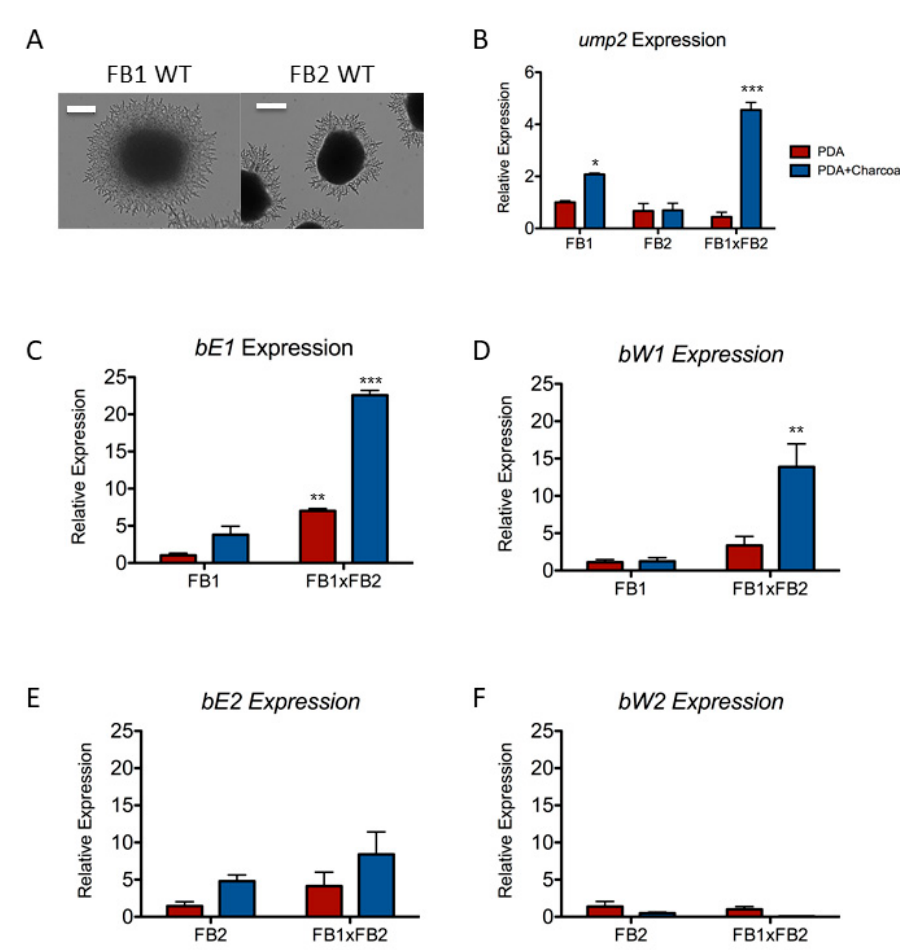
Figure 1. Phenotype of FB1 and FB2 under Low-NH 4 conditions. ( A ) Filamentous phenotype of FB1 and FB2 when grown on PDA media. Scale bars show, for FB1, 100 µ M; for FB2, 200 µ M. ( B ) Differential expression of ump2 on PDA vs. PDA supplemented with 1% activated charcoal. FB1 shows upregulation of ump2 on charcoal, as does the FB1xFB2 mated pair, while FB2 has similar levels of ump2 expression on both media. ( C ) bE1 expression on PDA vs. PDA-charcoal. FB1 expression level of bE1 shows a trend towards significance ( p = 0.07) on PDA-charcoal with respect to PDA. bE1 is significantly upregulated in FB1xFB2 on both PDA and PDA-charcoal. ( D ) bW1 expression on PDA vs. PDA-charcoal. The expression level of bW1 is the same on PDA vs. PDA-charcoal. In the FB1xFB2 mated pair, bW1 expression is significantly increased. ( E ) bE2 expression on PDA vs. PDA-charcoal. No change in bE2 expression was observed on either type of media, even in the mated pair FB1xFB2. ( F ) bW2 expression on PDA vs. PDA-charcoal. A similar trend was observed as with bE2 , with no difference in expression. For measuring relative levels of expression, the Comparative CT method (threshold cycle number at the cross point between amplification plot and threshold) was used and values were normalized to expression of the constitutively expressed gene, eif2B . Normalization was done using the Pfaffl Method [22]. Changes in gene expression are averages of at least three biological replicates and are displayed as log2-fold changes ± S.D., relative to expression of wild-type FB1 on PDA. Relative expression of each strain and/or condition was compared to the reference strain. All of the analyses were done using a one-way ANOVA with a Dunnett’s multiple comparison post hoc test. (* p < 0.05, ** p < 0.01, and *** p <